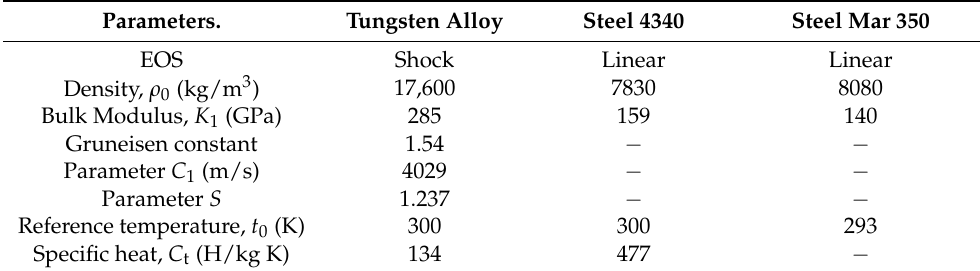
Table 4. Equation of state (EOS) constants for the tungsten alloy [29], steel 4340 [30] and steel Mar 350